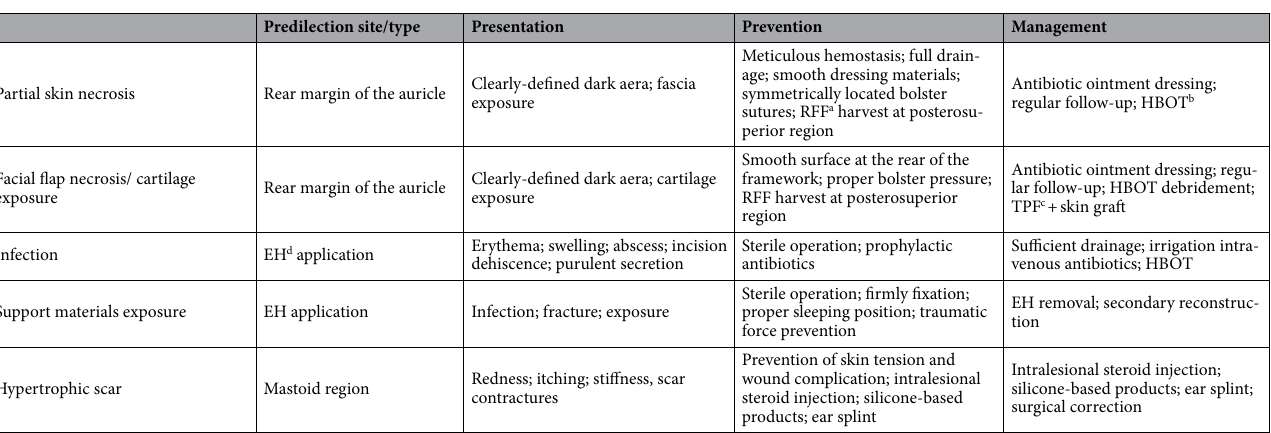
Table 4. Predilection site/type, presentation, prevention and management of complications after ear elevation. a RFF retroauricular fascia flap, b HBOT hyperbaric oxygen therapy, c TPF temporoparietal fascia flaps, d EH